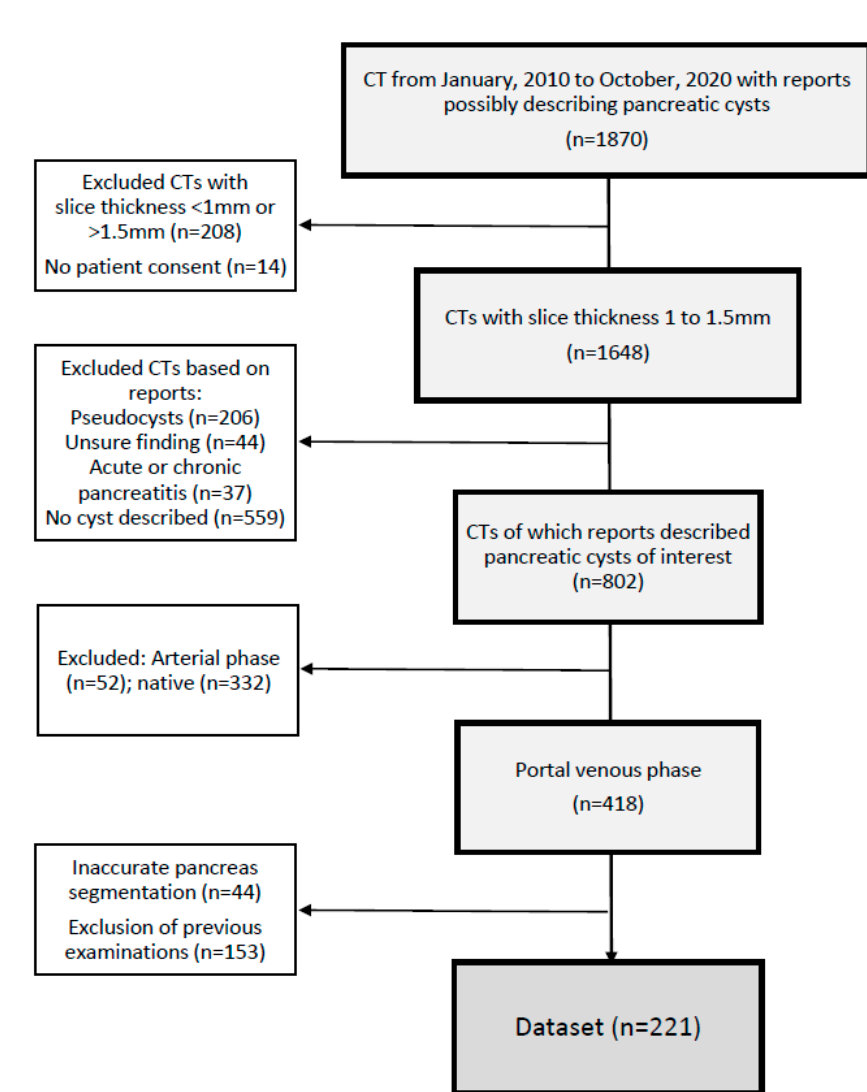
Figure 1. Study selection flowchart. The starting point was the collection of abdominal CTs